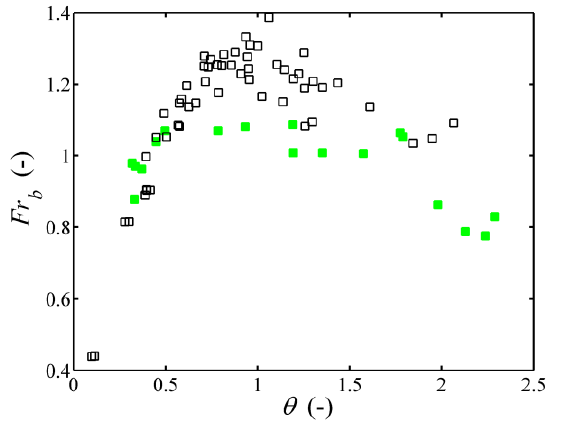
Fig. 8. Froude number dependent on shear stress, Legend: empty square – TLT50, full square – FA60.